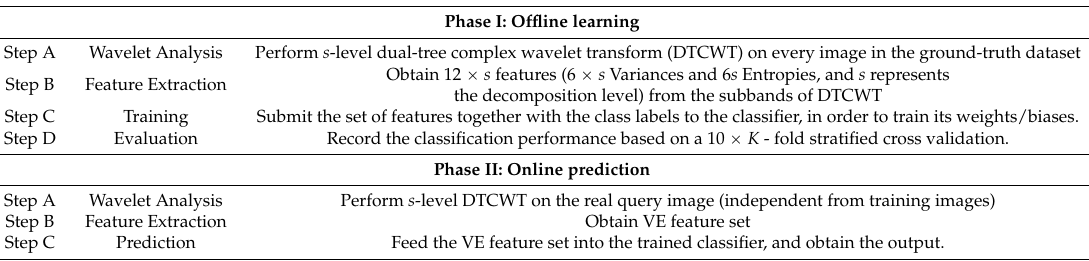
Table 1. Pseudocode of our system.